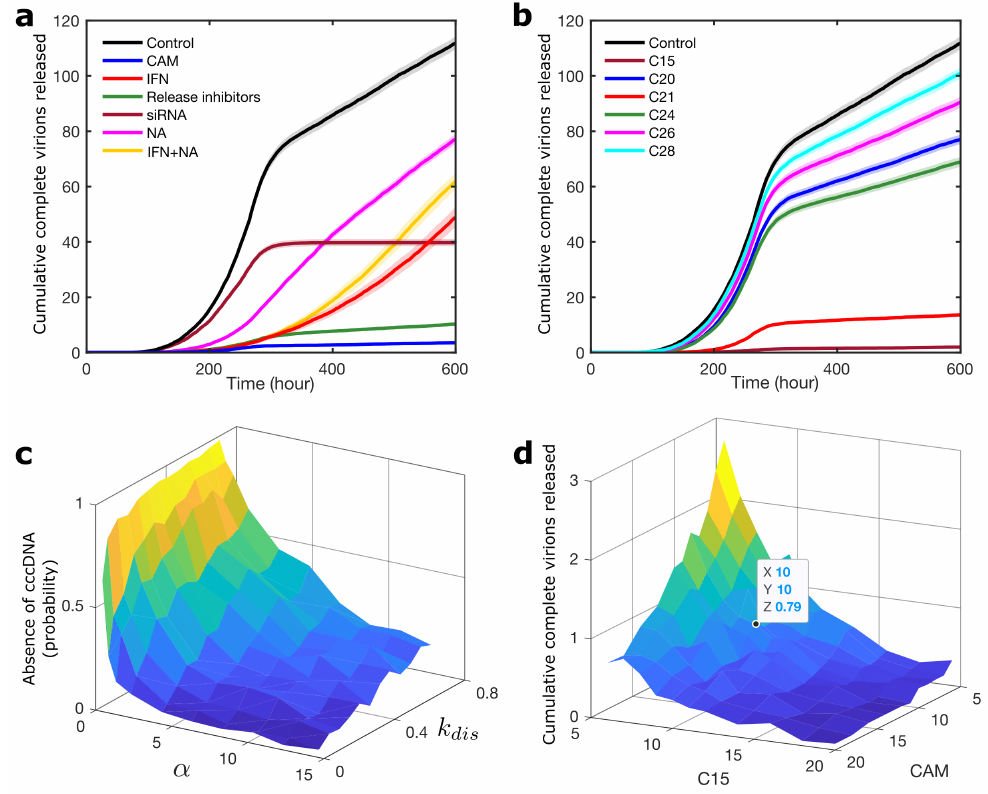
Figure 5. Comparative analysis of all possible treatment options for HBV, revealing a synergistic effect between nucleocapsid assembly inhibitors. ( a ) The dynamics of complete virions released with different treatment options after cccDNA formation for treatment starting once the initial condition cccDNA = 1 is reached in the model. A free concentration of 20 drug molecules is considered, except for NA, which is set to 100, and for IFN+NA, with IFN = 10 and NA = 50 (half concentration for each drug). Black shows the absence of treatment (Control) for comparison. ( b ) The dynamics of complete virions released after adding different PS-targeting compounds. ( c ) Impact of CAMs on the probability of prevention of cccDNA formation over 10,000 simulations after viral entry, starting with the initial condition rcNC = 1. We only focus on the cccDNA formation step (Step 1; Figure 1) when one rcNC has entered the cell. α is the delivery rate of rcDNA to the nucleus, and we assume that the conversion rate of rcDNA to cccDNA is 1 h − 1 ( a = 1 h − 1 ). ( d ) Synergistic effect between CAM and compound 15 (C15), with treatment starting once the initial condition cccDNA = 1 is reached in the model. The average number of released complete virions when the concentration of each drug is equal to 10 molecules is shown for clarity. This figure is plotted using parameter values from Supplementary Table